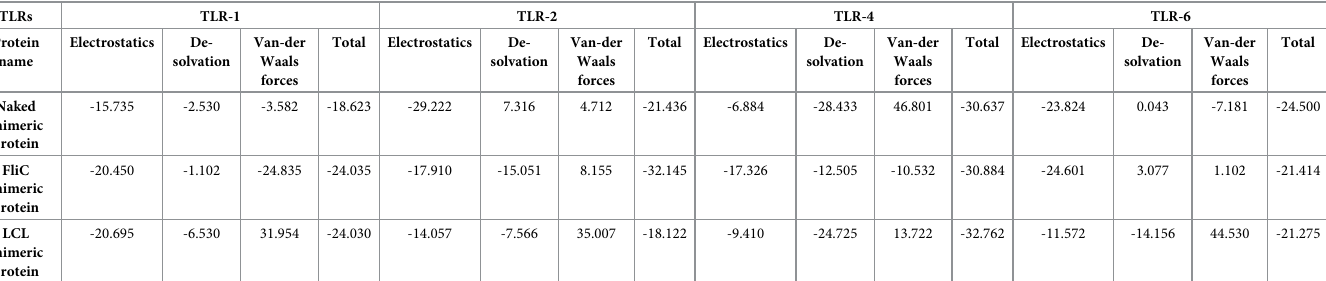
Table 3. Data on molecular dockings of multi-epitope vaccines with human TLR 1, 2, 4, and 6.